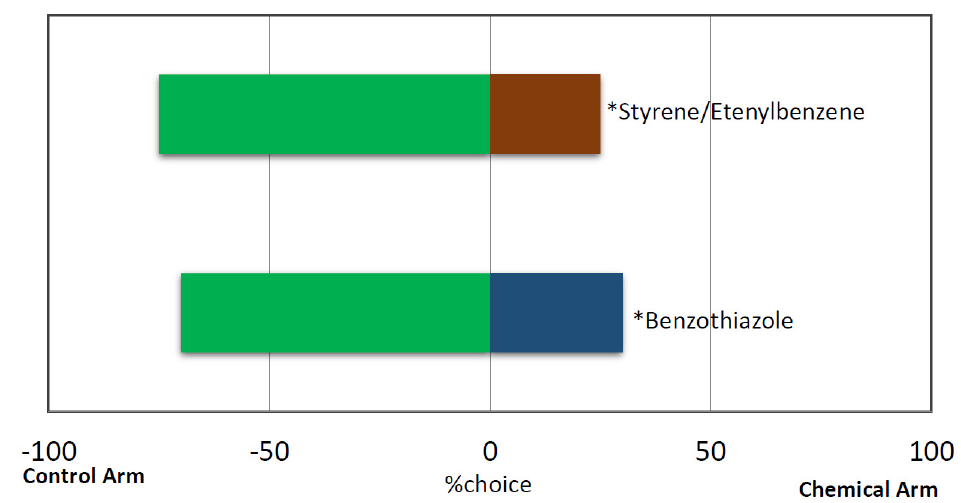
Figure 5. Response of female Rhynchophorus ferrugineus in a Y-tube olfactometer (10 min) when given a choice between environmental air (control) and odor stimulus (Chemical stimuli). N = 20 individuals per choice test. * Indicates significant difference within a choice test ( p < 0.01 chi-square).